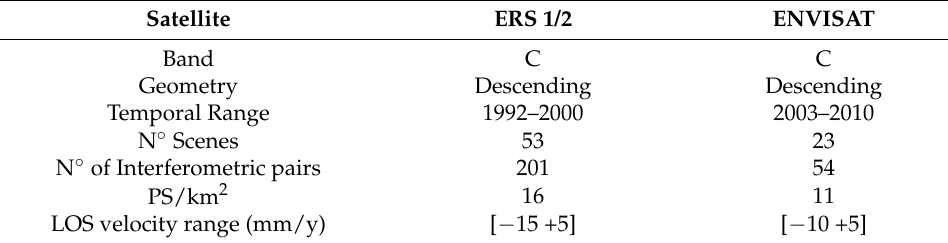
Table 1. Characteristics of the satellites used and post-processing information.